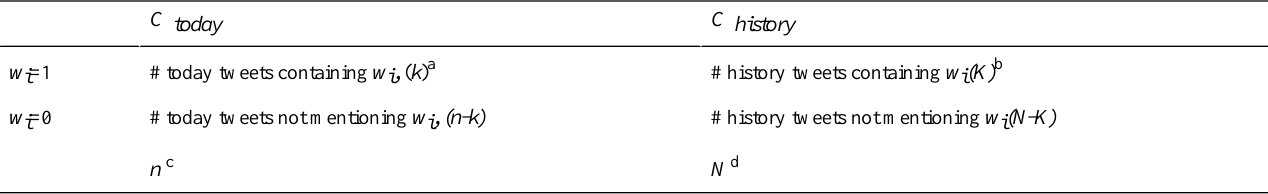
Table 3. The 2×2 contingency table (rule wi =1: tweet contains keyword wi ) for Fisher’s exact test.